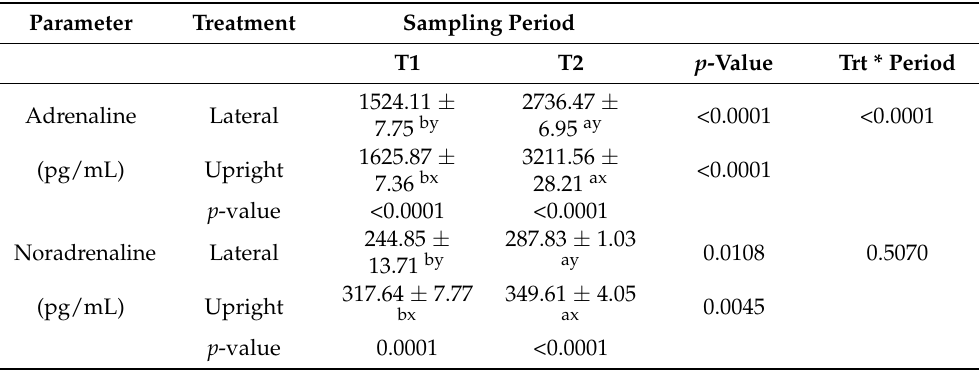
Table 2. Changes in catecholamine parameters in cattle subjected to slaughter positions before slaughter (T1) and after neck cut (T2).